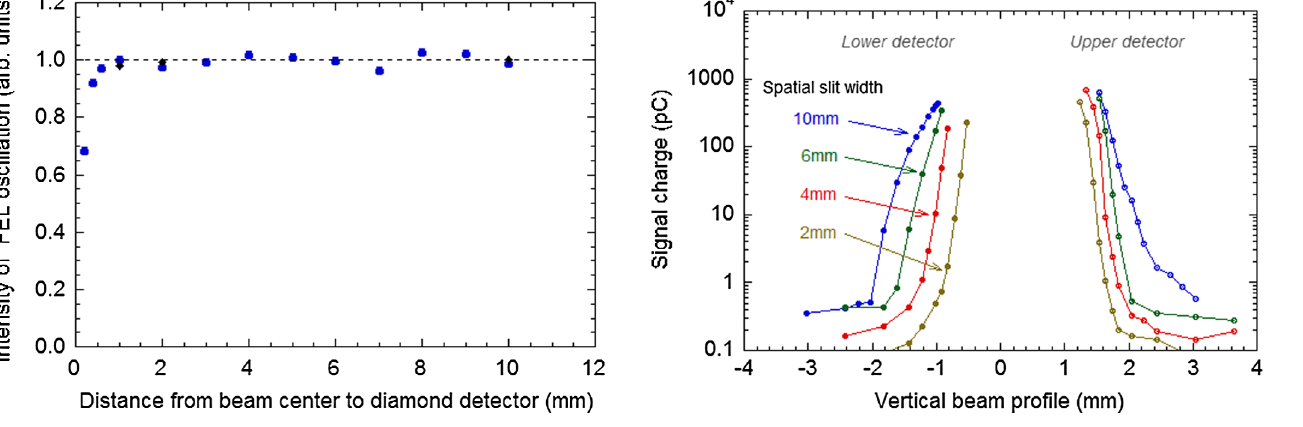
FIG. 16. Scanning measurements for various spatial slit widths. The numbers are the widths of the spatial slit. (The aperture size of the energy filter was fixed to 10